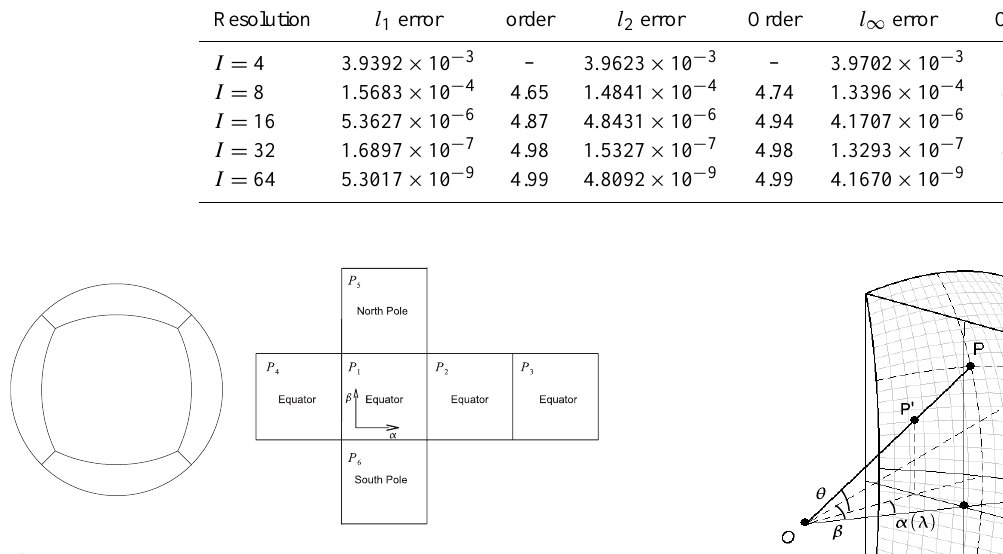
Figure 4. The cubed-sphere grid.